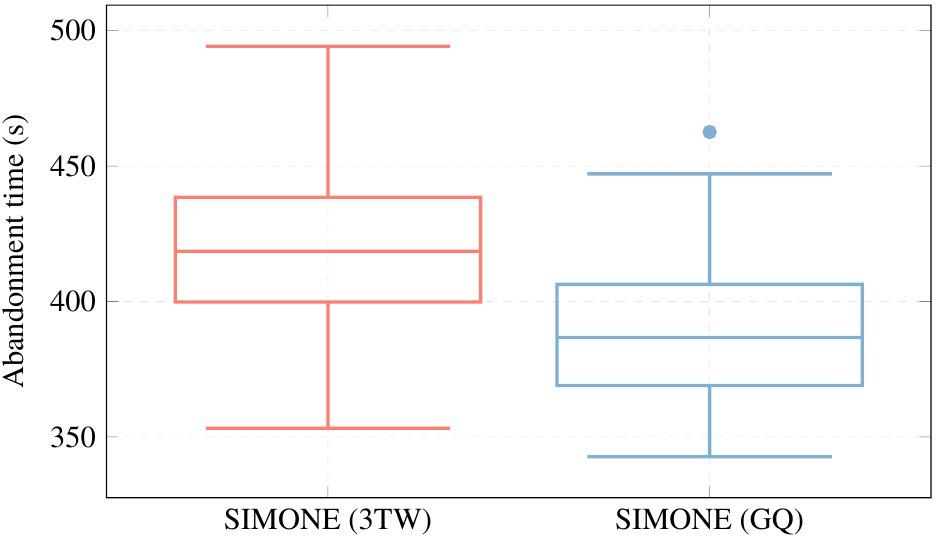
Figure 10. Box plots, abandonment times (SIMONE) for the 3 TW and GQ starting